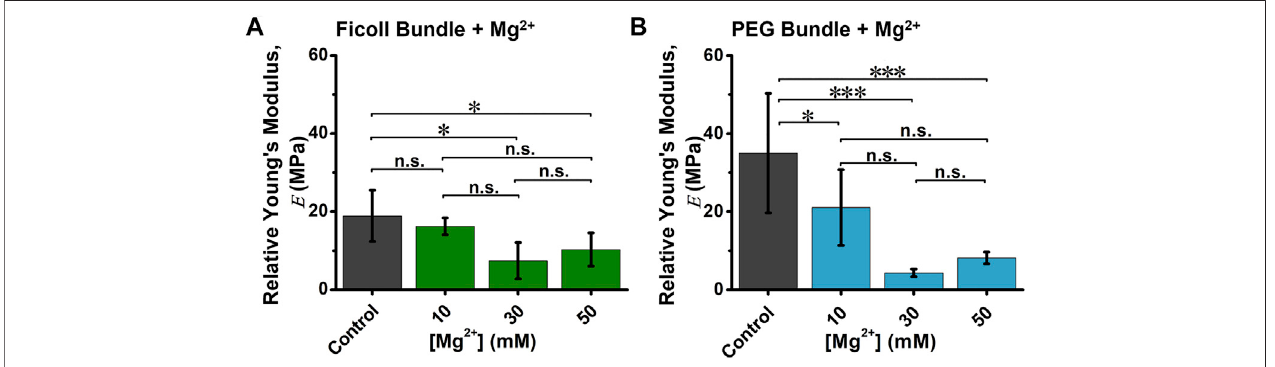
FIGURE4| TherelativeYoung ’ smodulus( E )ofdepletion-inducedbundleintheabsenceandpresenceofvarying(Mg 2+ ).Quanti fi cationofaverage (A) Ficoll-inducedor (B) PEG-induced actin bundle E in 10 – 50 mM (Mg 2+ ). Depletion-induced bundle E was fi tted using Hertz model, and signi fi cant difference to bundles was determined by Tukey test(n.s.,notsigni fi cant;* p < 0.05, ** p < 0.01,*** p < 0.001).Totalnumber offorcecurvesanalyzed per condition N ≈ 150,and